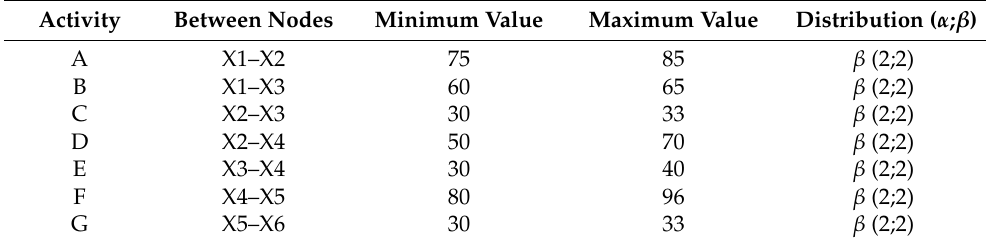
Table 4. Activity durations.